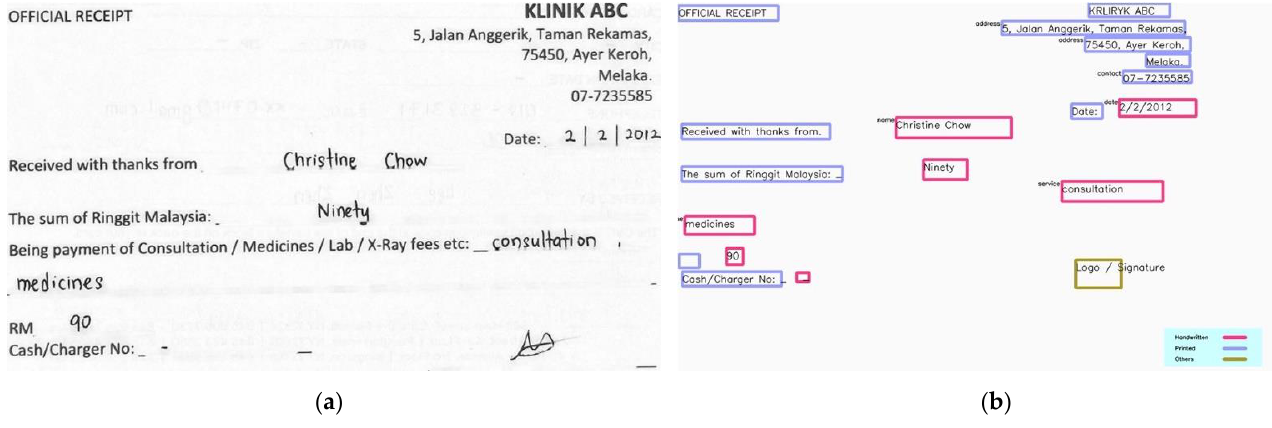
Figure 12. Sample input and output I: ( a ) input; ( b ) output.